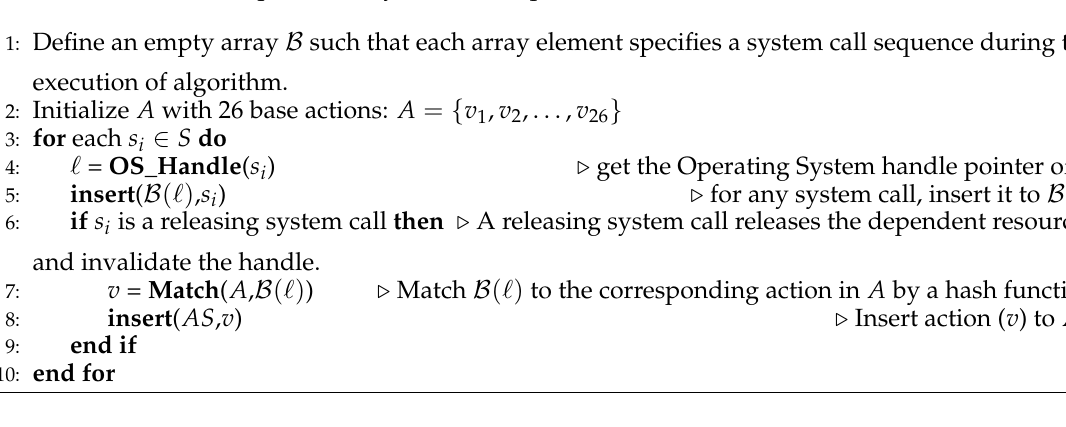
Algorithm 1 : Preprocessing , generating an action sequence from a system call